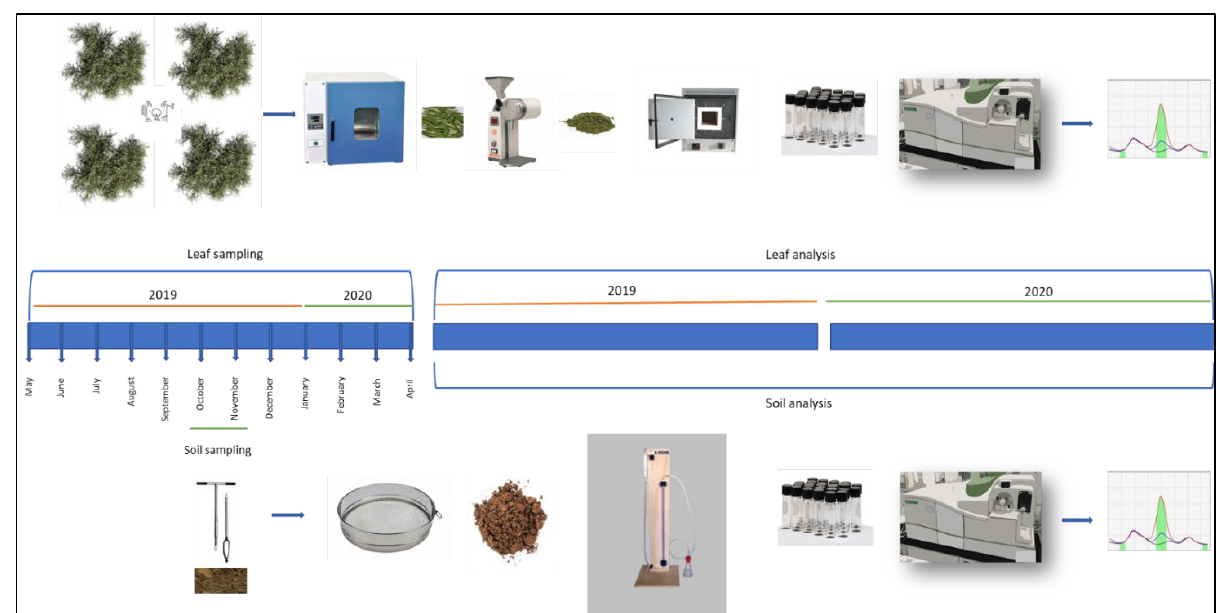
Figure 2. Schematic illustration of leaf and soil analyses over time.